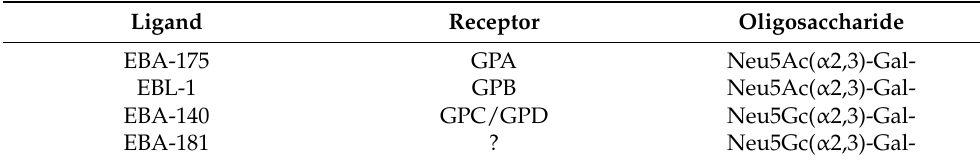
Table 1. P. falciparum EBL merozoite ligands and glycophorin RBC receptors. Ligand Receptor